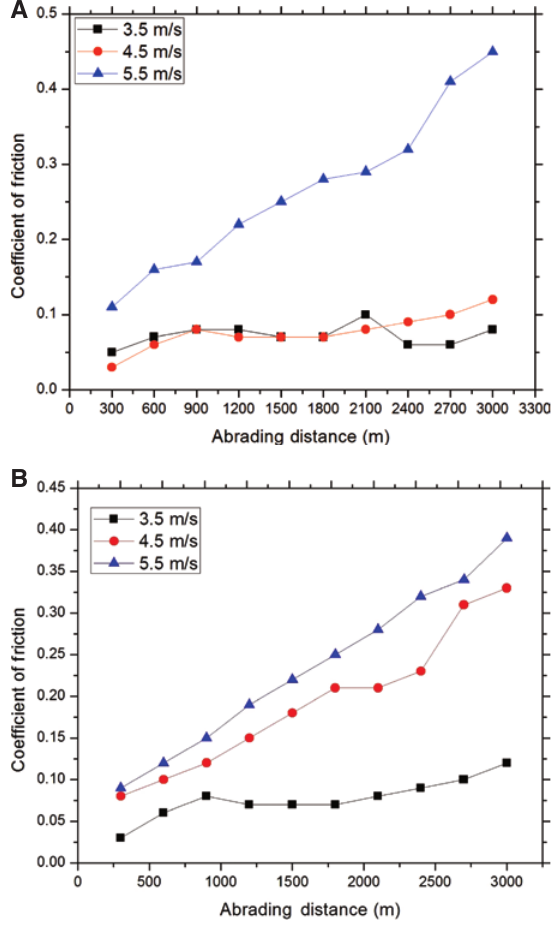
Figure 6 Effect of sliding velocity on coefficient of friction, run at 10 N load: untreated composites (A) and alkali-treated composites (B).